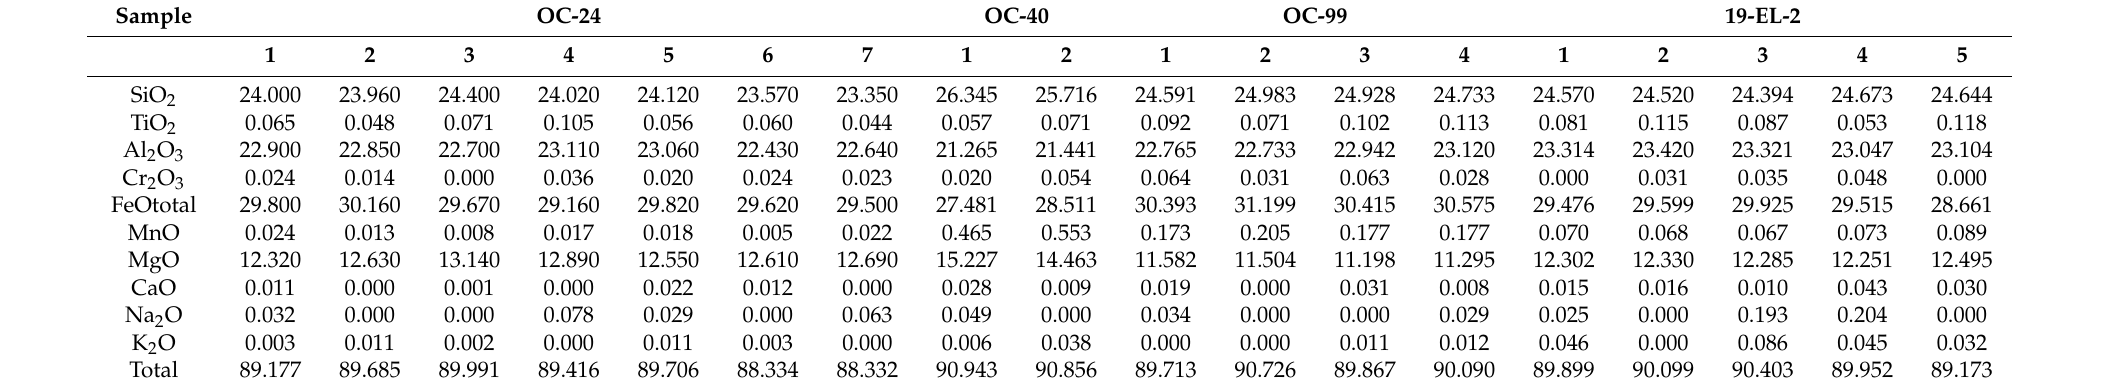
Table 3. Chlorite compositions and data on chlorite